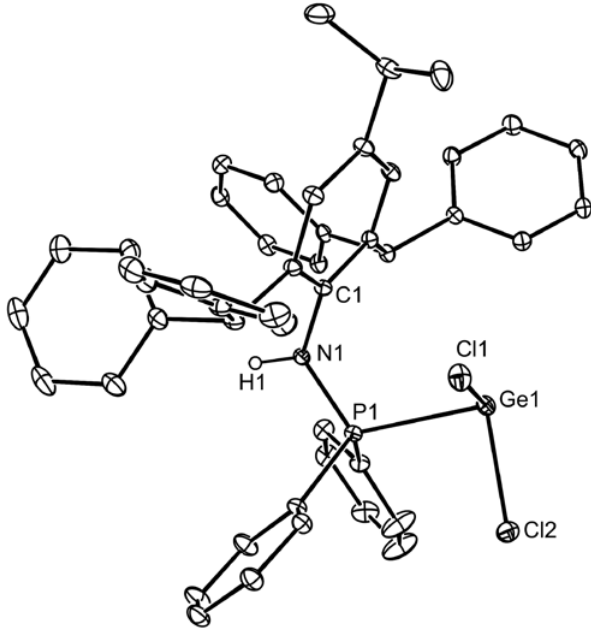
Figure 2: Thermal ellipsoid plot (30% probability surface) of the molecular structure of 2 [hydrogen atoms, except H(1), omitted]. Selected bond lengths (Å) and angles ( ° ): Ge(1)-Cl(1) 2.2451(7),